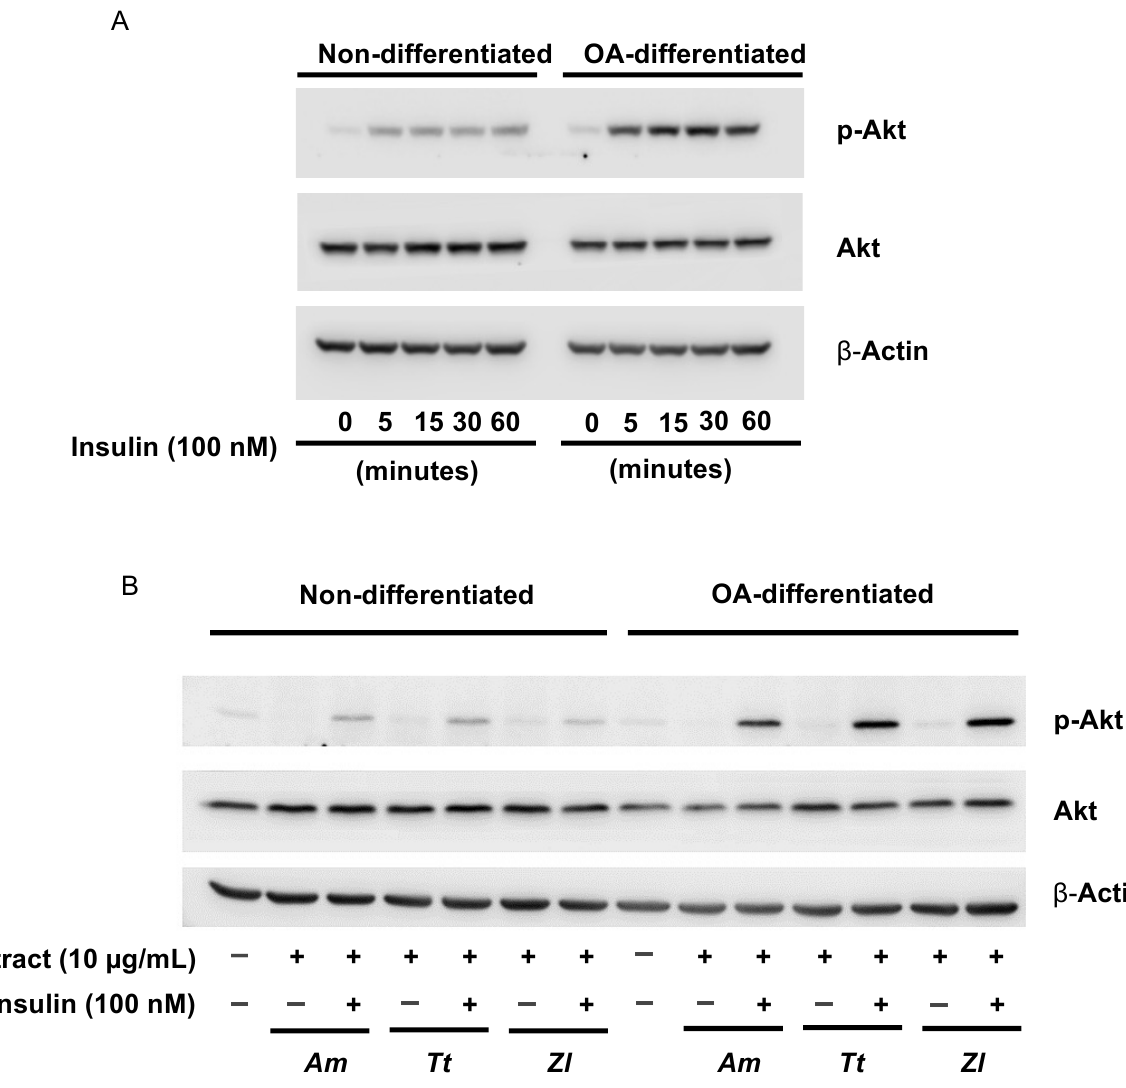
Figure 3. Akt phosphorylation dynamics in differentiated and non-differentiated SW 872 cells. ( A ) Time course of Akt phosphorylation upon treatment with 100 nM insulin. ( B ) Combined effect of 24-h exposure to 10 µ g/mL spice extracts ( A. melegueta ( Am ), Z. leprieurii ( Zl ) and T. tetraptera ( Tt )) and 1-h treatment with 100 nM insulin on Akt